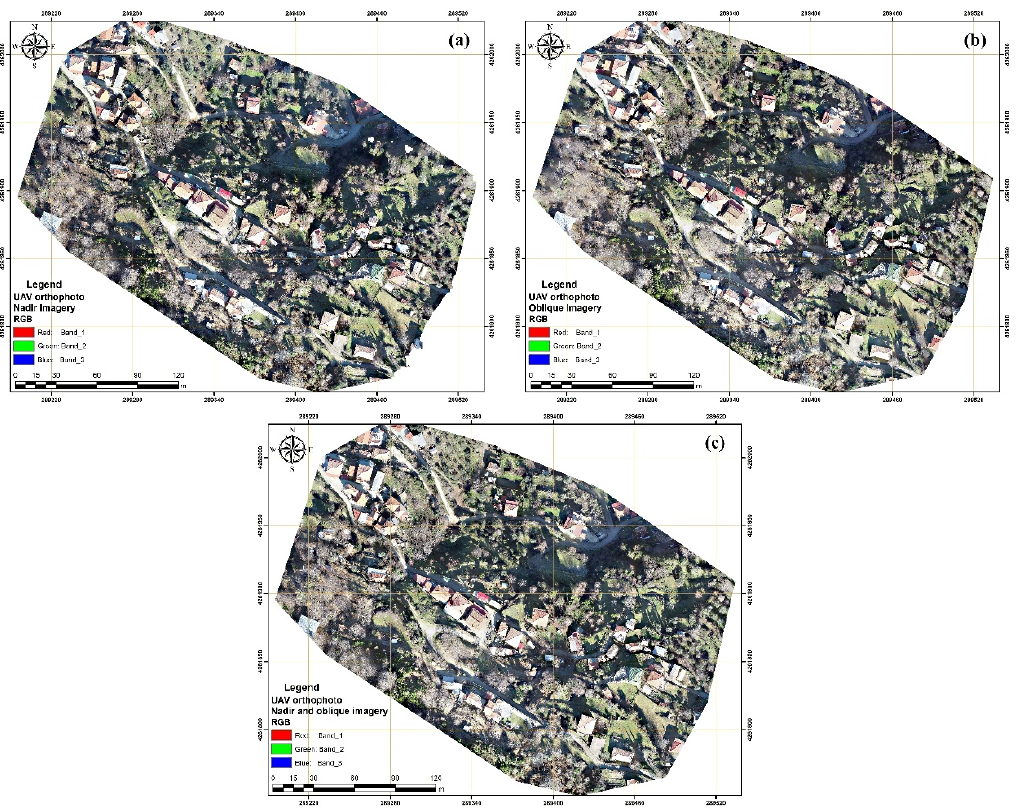
Figure 6. UAV orthophotos of the landslide of Messarista, emerging from the processing of ( a ) nadir- viewing images, ( b ) oblique-viewing images, and ( c ) synergistic use of nadir and oblique images. The scale of the orthophotos was set to